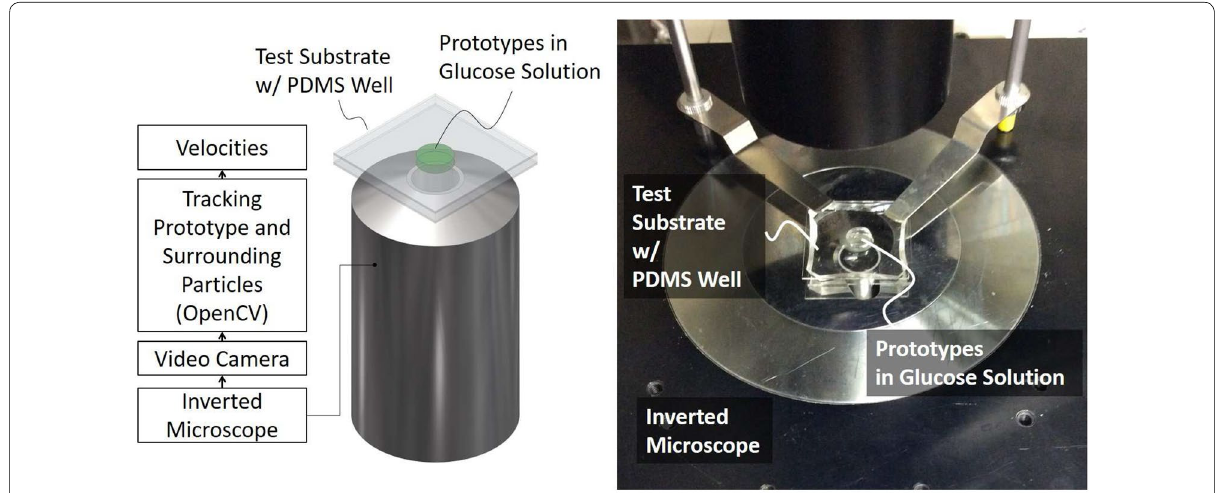
Fig. 3 Experimental